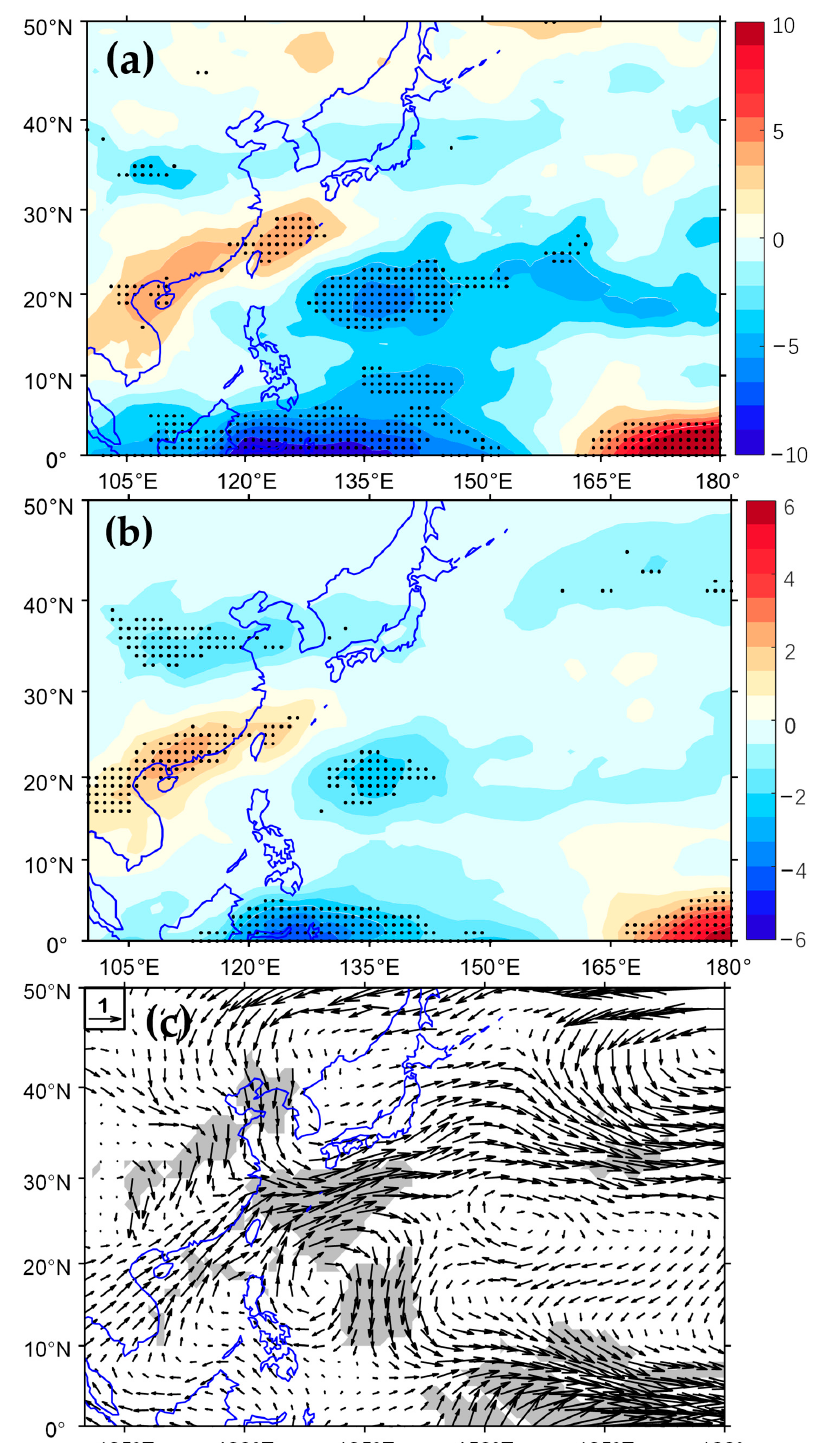
Figure 6. The differences (SP minus SU) in the ( a ) relative humidity at 600 hPa (unit: %), ( b ) TCWV (unit: kg·m − 2 ), and ( c ) horizontal wind (unit: m·s − 1 ) at 850 hPa during the typhoon season of SP and SU El Niño years. The ( a , b ) dots and ( c ) shaded areas mark the areas that were statistically significant at the 95% confidence